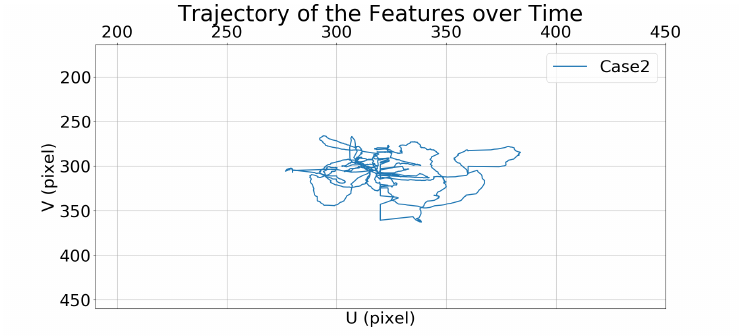
Figure 16. Simulation 2: trajectory of the moving target in the image frame for Case 2. The performances are quantified based on the RMS tracking errors defined in Table